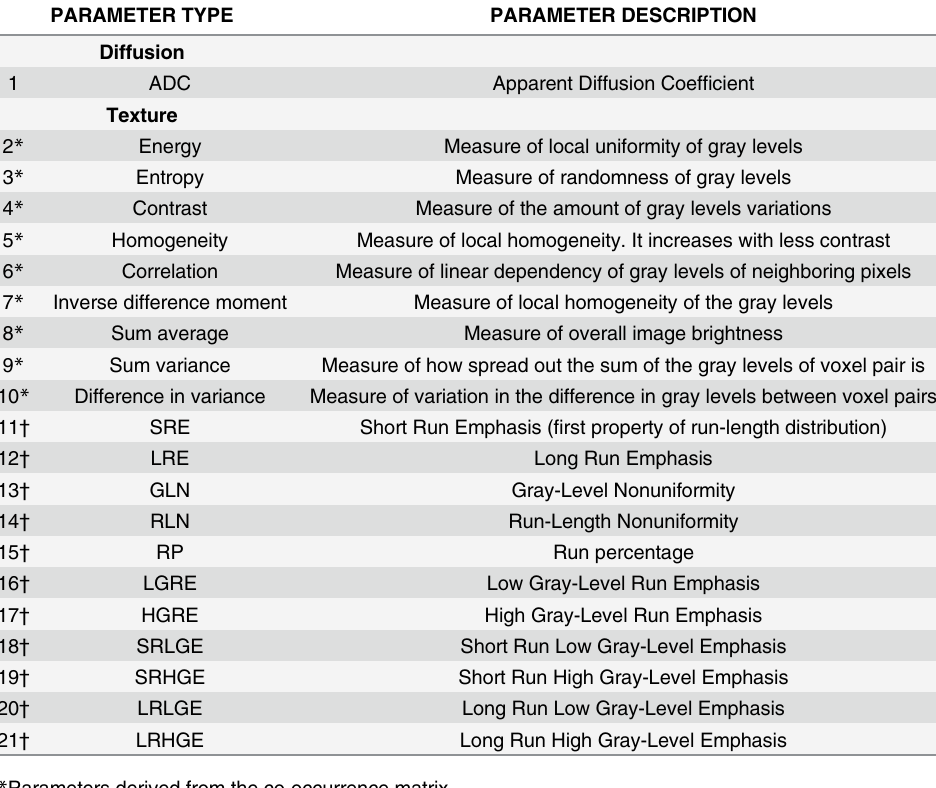
Table 1. List of parameters used for the characterization of MS